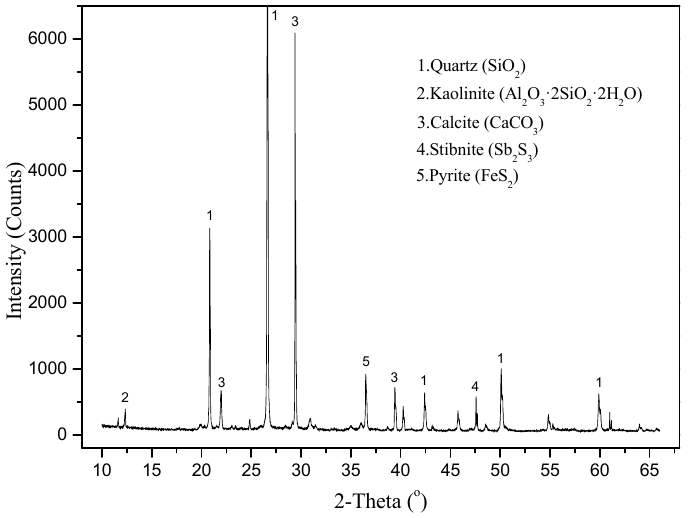
Figure 3. XRD analysis of typical ore waste.